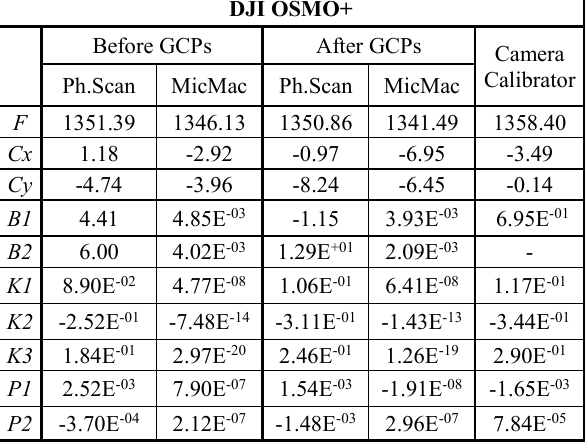
Table 9. Calibration parameters for the DJI OSMO+ evaluated with self-calibration before and after placing GCPs and parameters estimated by MatLab Single Camera Calibrator